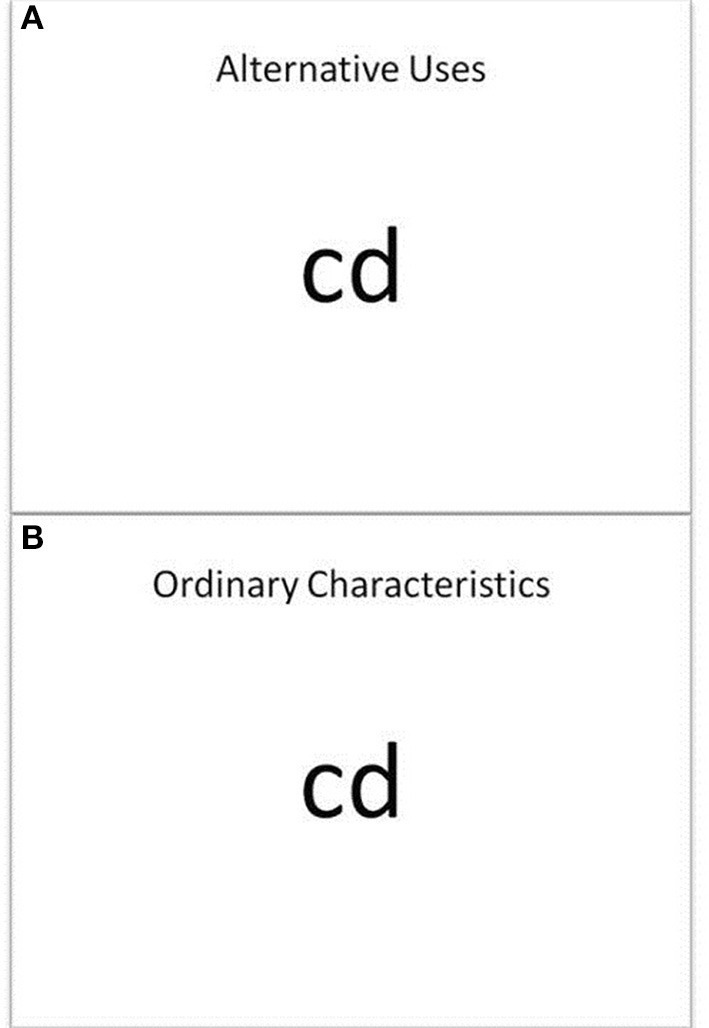
Alternative Uses/Ordinary Characteristics task: (A) example Alternative Uses item and (B) example Ordinary Characteristics item. Participants were asked to list as many alternative uses for or ordinary characteristics of an everyday object as possible.